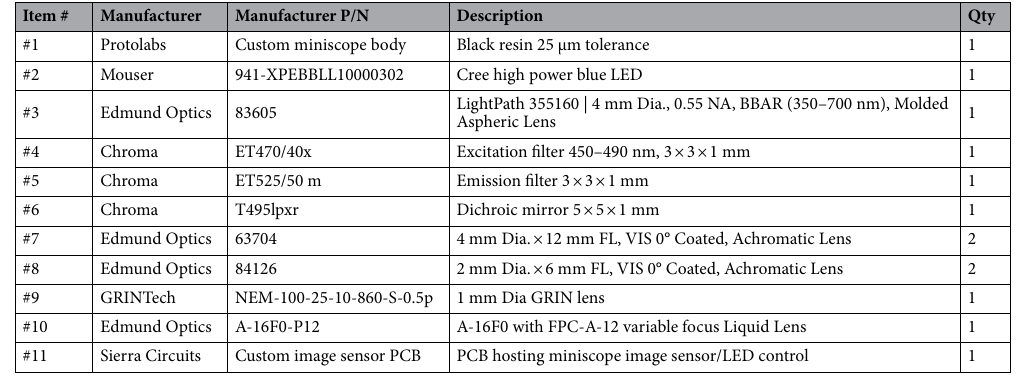
Table 1. Bill of